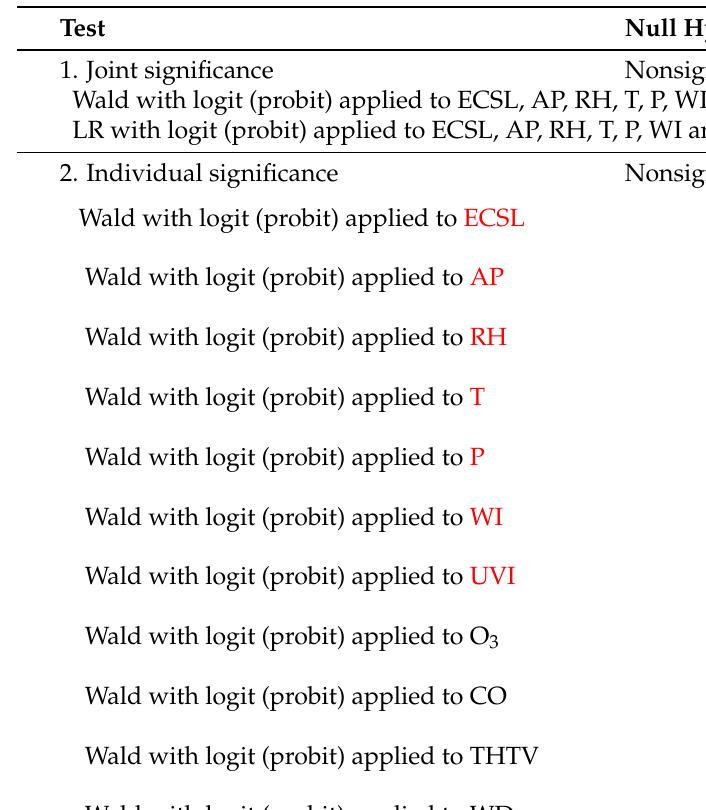
Table 4. Hypotheses testing for individual and joint significance of input